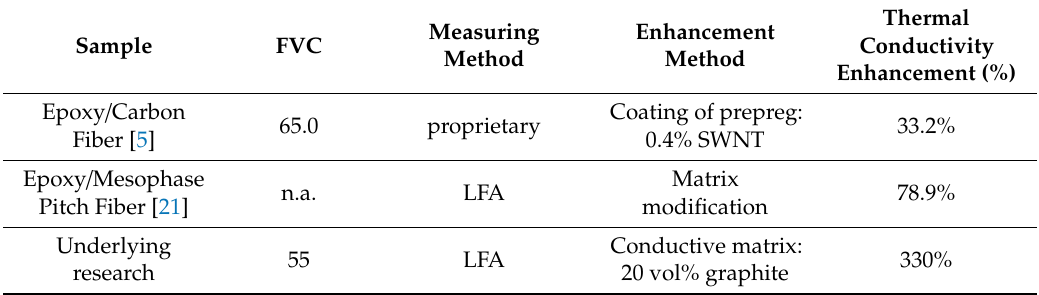
Table 1. Transverse conductivities of samples from the literature and their fiber volume content (FVC) and measurement methods as Laser Flash Analysis